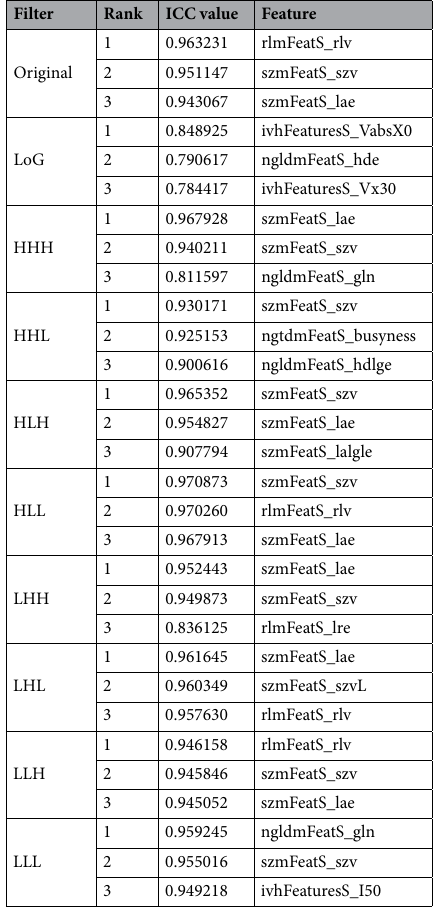
Table 4. ICC values of top 3 features for radiologist derived contours per filtered image. Feature definitions and calculation provided by Computational Environment for Radiological Research (CERR) 35 , as recommended by the imaging biomarker standardization initiative (IBSI) 36